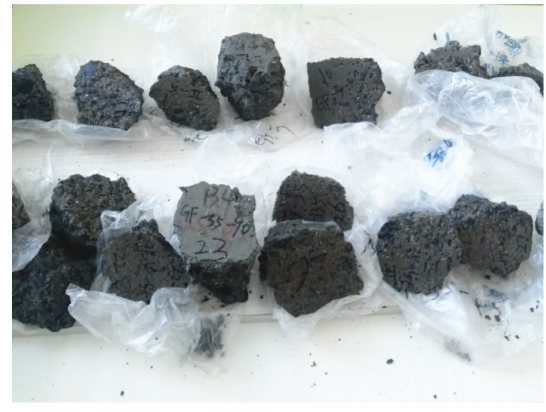
Figure 2. A portion of the blocks after freeze-thaw